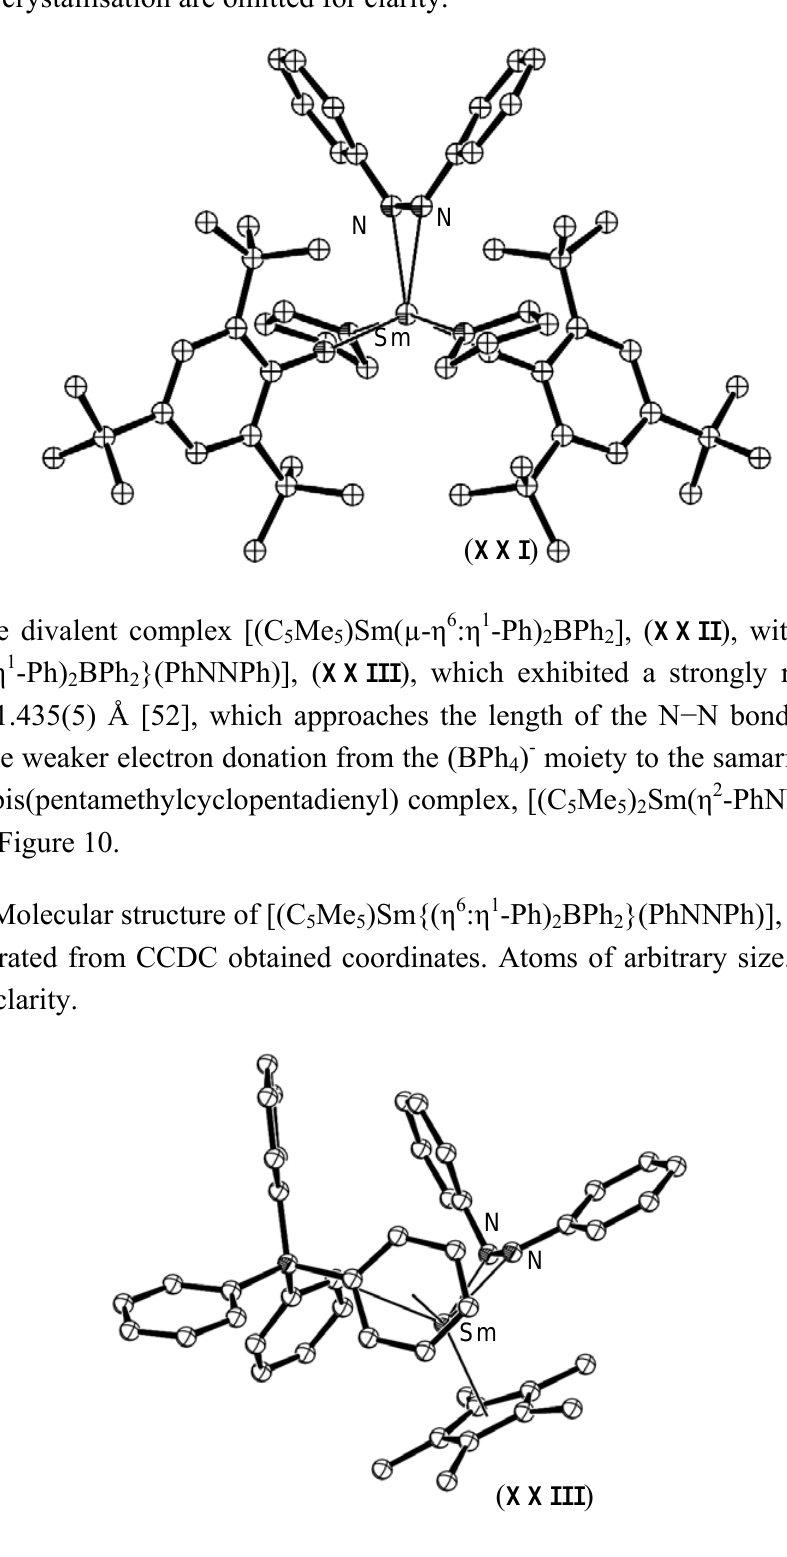
(PhNNPh)], ( XXI ) [51]. Figure generated from Figure 9. Molecular structure of [Sm(OAr) 2 CCDC obtained coordinates. Atoms of arbitrary size. H atoms and one diethyl ether molecule of crystallisation are omitted for clarity.